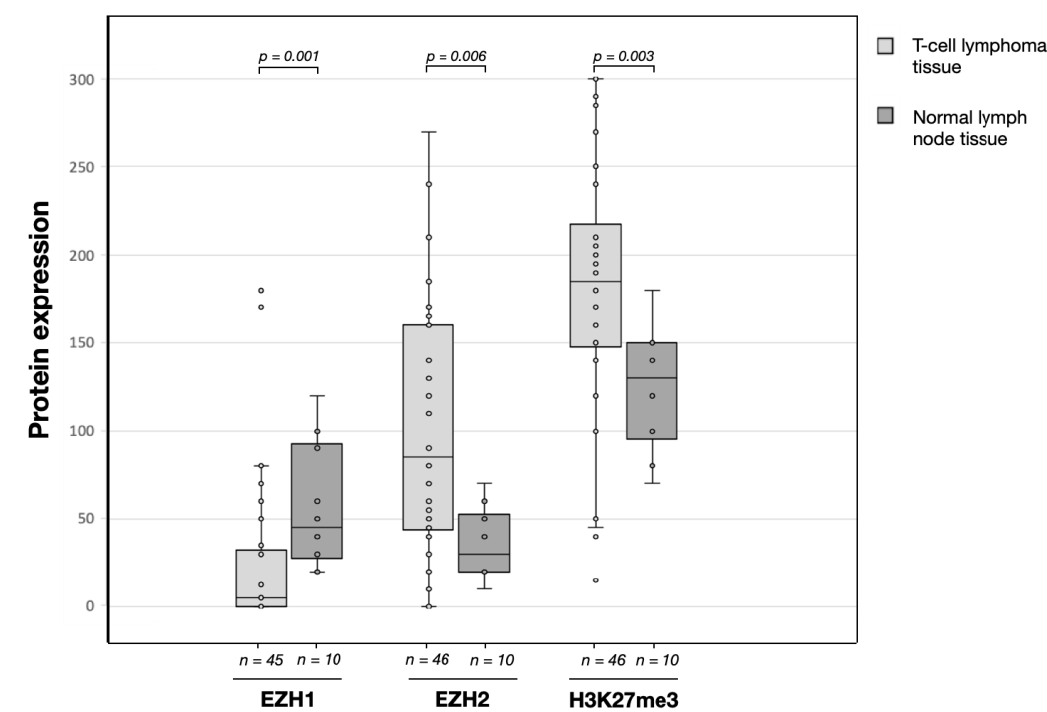
Figure 2. EZH1, EZH2, and H3K27me3 protein expression (H-score) in T-cell lymphomas and non-tumor tissues analyzed by immunohistochemistry. Boxplots represent the median and interquartile range of protein level (H-score). The number ( n ) of tissue samples is given below. p -values are shown above.